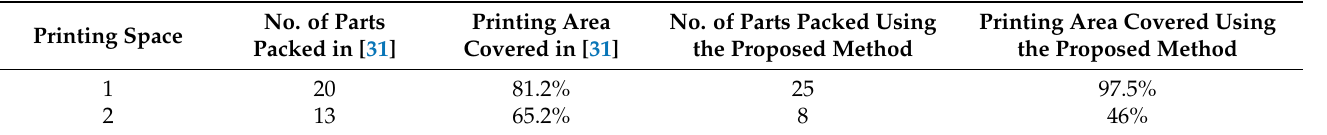
Table 5. Packing density comparison between the method in the study in [31] and the pro- posed method.